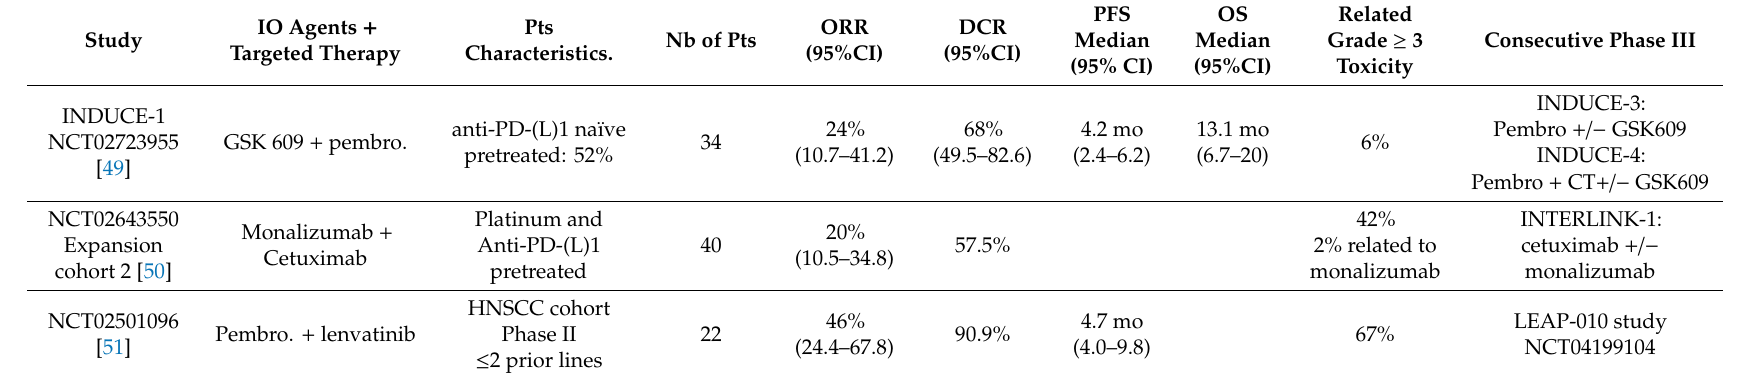
Table 5. Future developments with new IO agents and new combinations in R / M pretreated